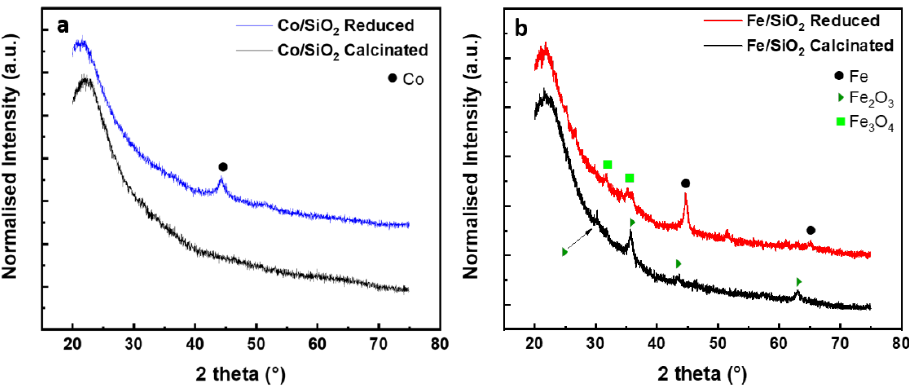
Figure 2 . XRD spectra of ( a ) SiO 2 /Co after reduction/ calcination and ( b ) SiO 2 /Fe after reduction/ calcination. Figure 2. XRD spectra of ( a ) SiO 2 /Co after reduction/calcination and ( b ) SiO 2 /Fe after reduc-